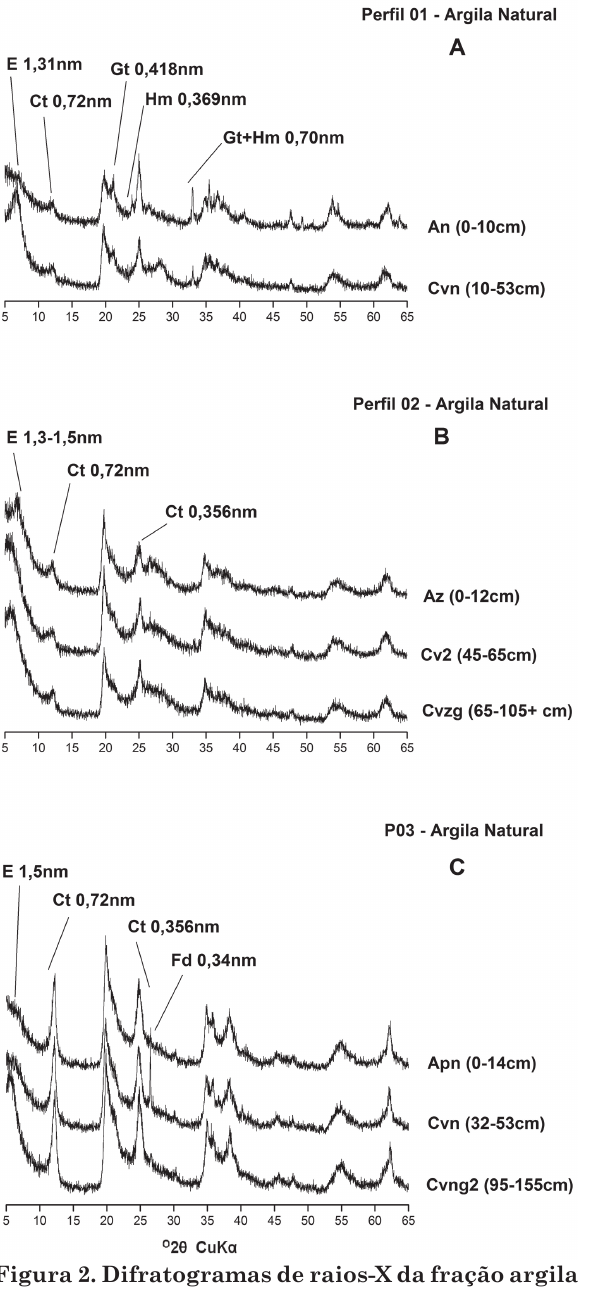
Figura 3. Difratogramas de raios-X da fração argila do perfil 1 - VXo solódico (E-esmectita; I-ilita; Ct-caulinita; e